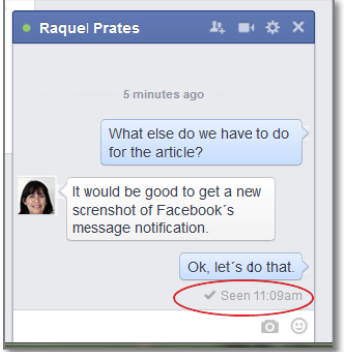
Fig. 2. Facebook chat/message interface notifies user that his/her message has been seen by the recipient.